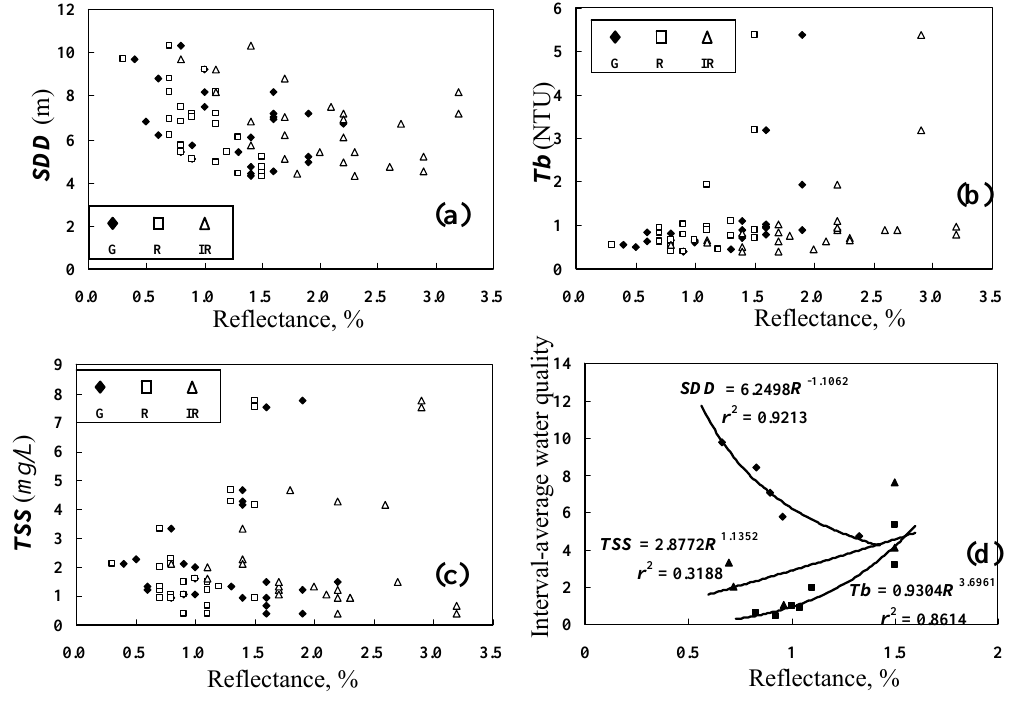
Figure 6. Scatter plot of water quality measurents versus band-dependent sea surface reflectances. (a), (b), (c) Original water quality measurements, (d) interval-average water quality